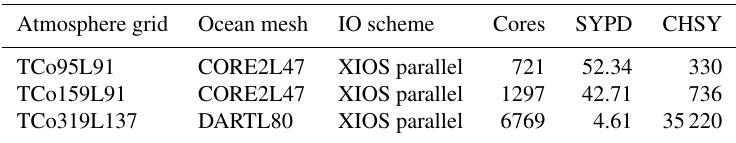
Table 3. As Table 2 but optimized for computational cost instead of integration speed by limiting total core numbers within the limit of linear strong scaling.